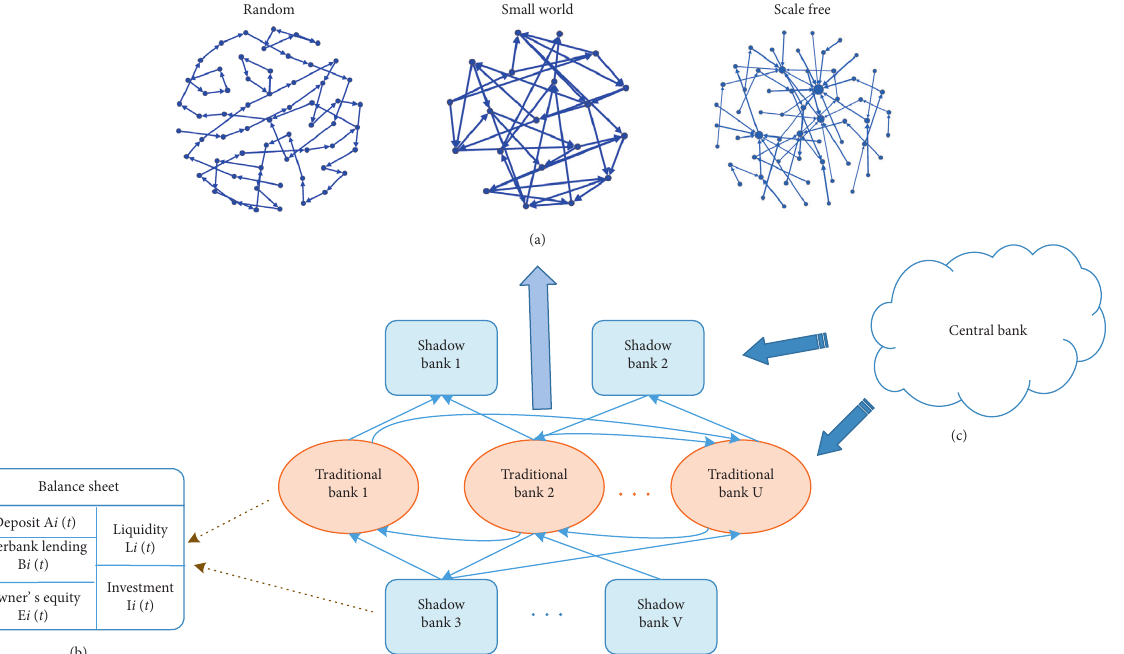
Figure 1: The structure of the banking system with shadow banking under various interbank